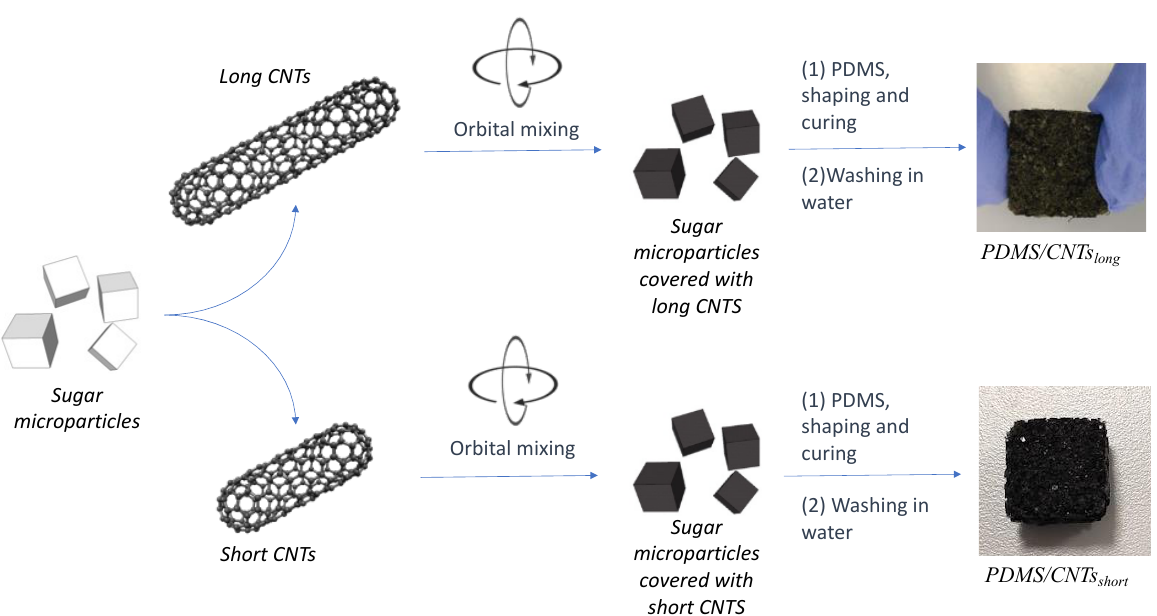
Figure 2. Fabrication scheme of the PDMS/CNTs foams with different carbon nanotube length .